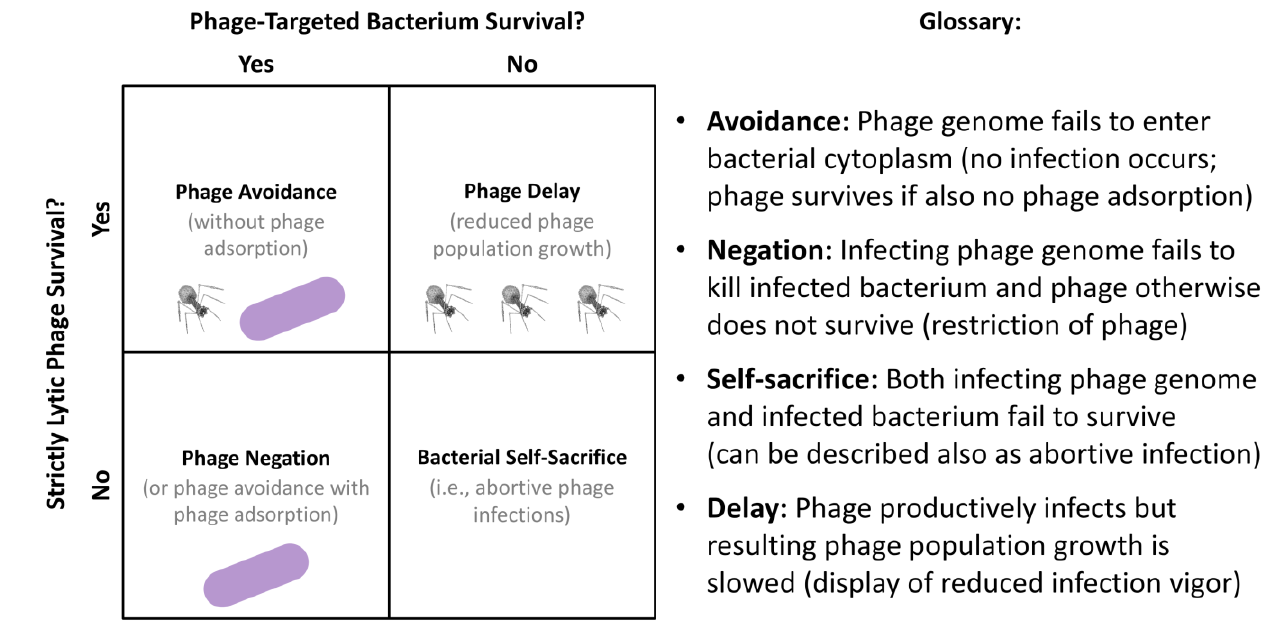
Figure 6. Distinguishing mechanisms of bacterial inhibition of phage activity in terms of phage vs. bacterial survival. Illustrations refer to either bacterial survival (purple bacilli as found to the far left), would-be infecting phage survival (upper-left of the 2 × 2 matrix), or some degree of successful phage amplification in numbers (upper-right also of the 2 × 2 matrix). Bacterial self-sacrifice, as defined here (lower-right, 2 × 2 matrix), results in survival of neither an infecting phage nor the phage-infected bacterium. Not shown is a productive lytic phage infection of a fully phage-susceptible bacterium, which would result in a combination of greater phage production than that seen with phage delay, for example (upper-right, 2 × 2 matrix), along with a loss of viability of the phage-infected bacterium. Categories of bacterial interference with phage infection activities and antibacterial action are defined to the right. Discussion of these mechanisms of bacterial resistance can be found in Box 3.